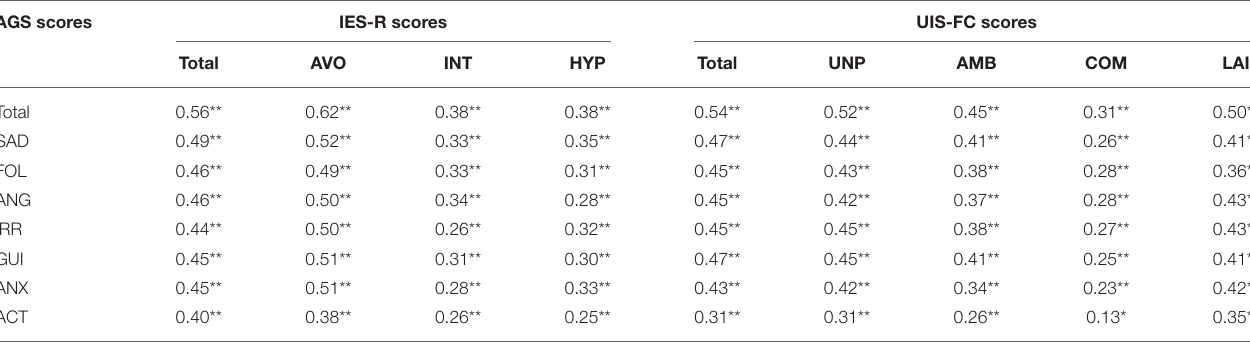
TABLE 1 | The interrelationships between PTSS, IU and AG (r). AGS scores